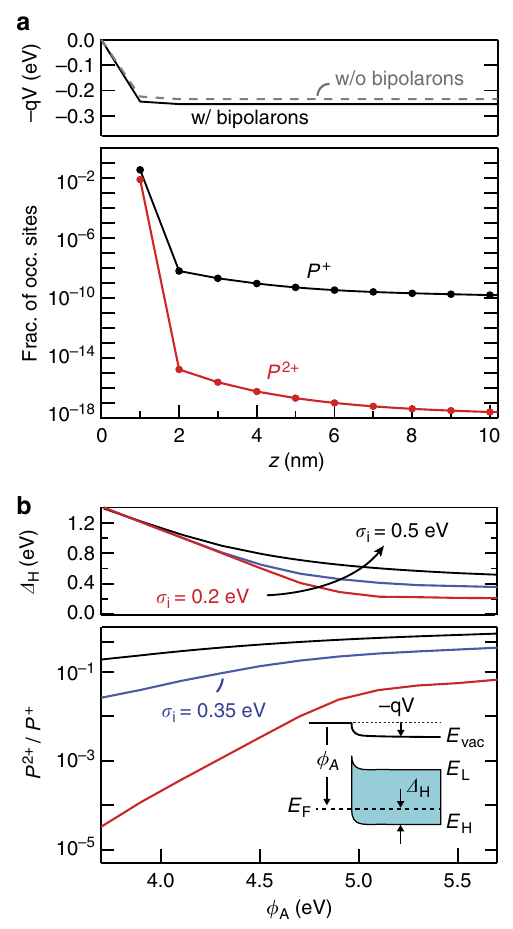
Fig. 5 Bipolaron model predictions. a Polaron and bipolaron densities (lower panel) and potential shift (upper panel) calculated for each monolayer of TPD assuming σ i = 0.35 eV, σ b = 0.1 eV, an ITO work function ϕ and a TPD ionization potential IP = 5.1 eV (de fi ned as the onset of g 0 standard deviations less than its peak at IP + 2 σ b = 5.3 eV). The density of TPD molecules is assumed to be 10 21 cm − 3 , with each monolayer being 1 nm thick. The gray dashed line in the upper panel shows the potential shift calculated for the same system without the possibility of bipolaron formation. b The lower panel shows the bipolaron-to-polaron ratio in the fi rst monolayer calculated for varying anode work function and different σ The upper panel shows the associated variation in hole injection barrier shown in the inset ( Δ H is de fi ned as the difference between E F and the HOMO onset in the bulk), where Fermi level pinning occurs at ϕ A > 5